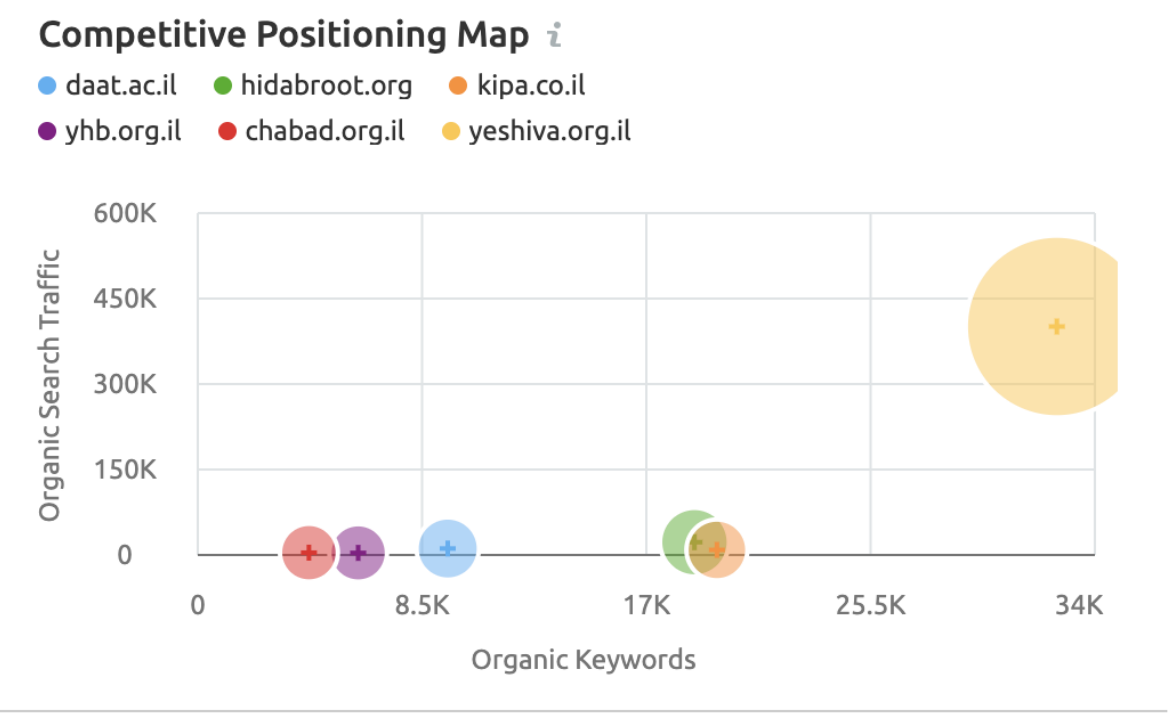
Figure A1. Semrush Tools Report on the Competitive Position of Yeshiva.org.il (accessed on 6 November 2020) Compared to Other Sites in Israel.